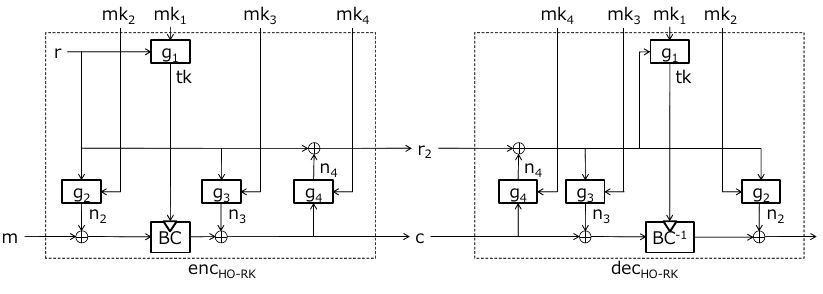
Figure 12. Higher order SCA-resistant re-keying scheme.